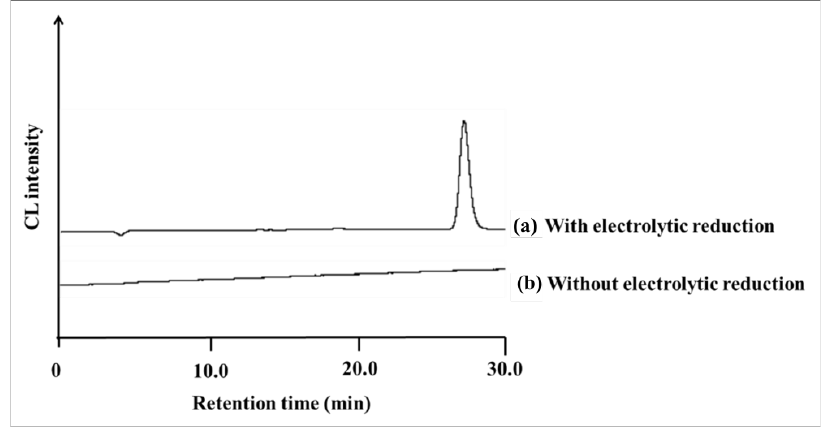
Figure 3. Chromatograms of 1.0 μM UQ standard obtained ( a ) with electrolytic reduction and ( b ) Figure 6. Chromatograms of 1.0 µ M UQ standard obtained ( a ) with reduction column and ( b ) without without electrolytic reduction by HPLC-CL detection. reduction column by HPLC-CL